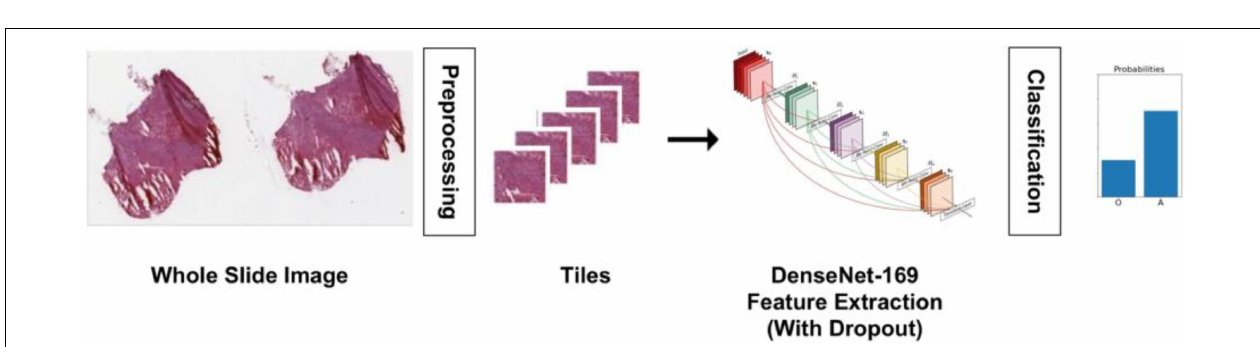
FIGURE 6 | Histopathology image analysis pipeline. The whole slide tissue images are pre-processed to detect tissue, do color normalization, and extract tiles. The tiles are input to a DenseNet model for classification. The model outputs the probability of a case being oligodendroglioma or astrocytoma.